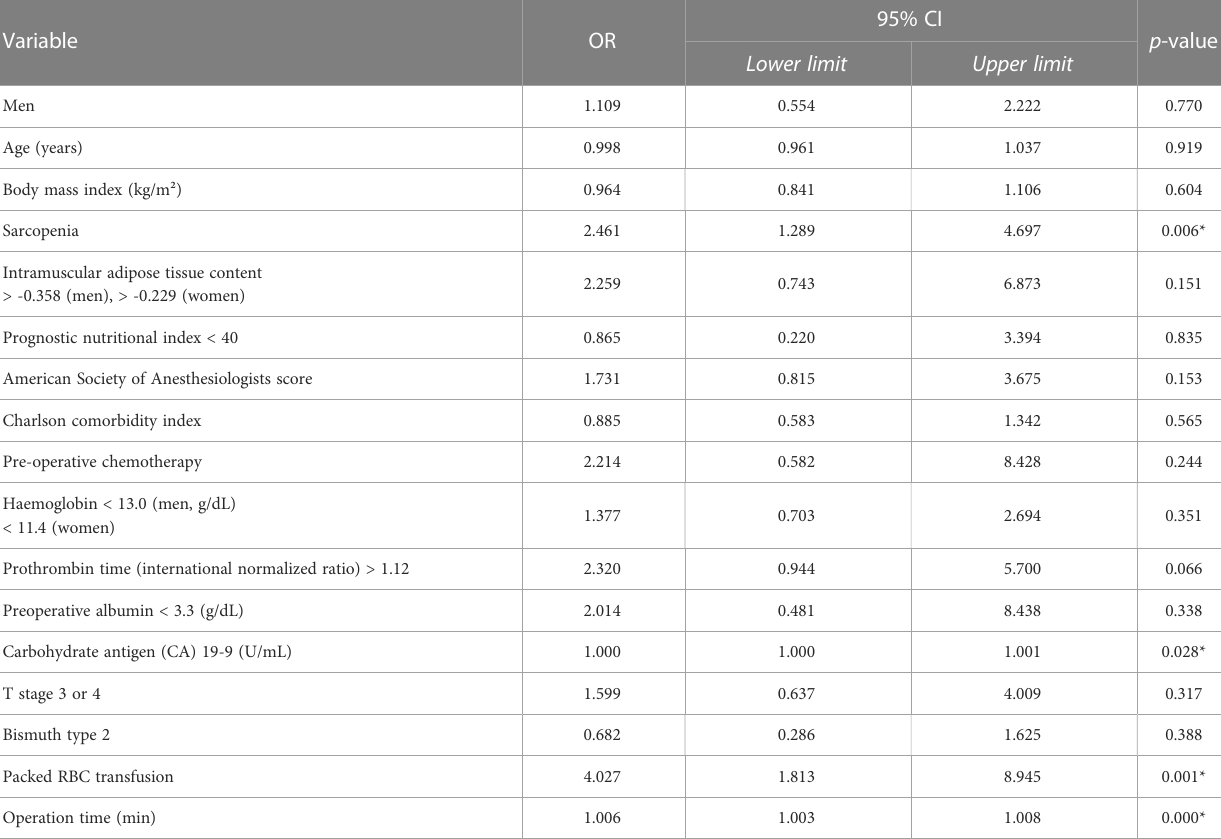
TABLE 3 Multivariate logistic regression analysis for risk factors of postoperative ICU